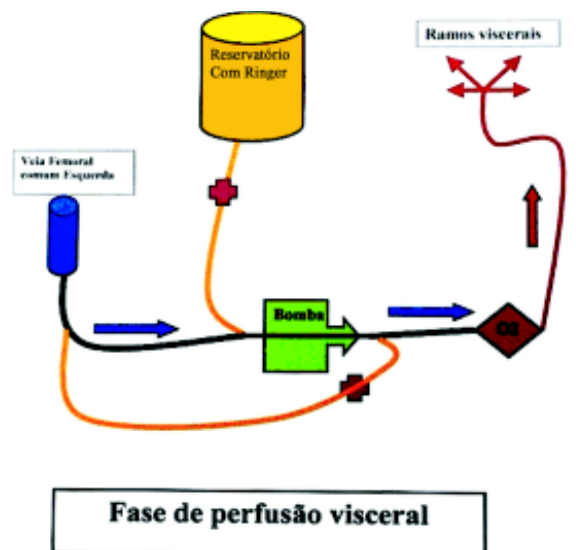
Fig. 1 - Em amarelo reservatório de cardiotomia e a linha de conexão no circuito. Nesta fase estas linhas encontram-se pinçadas (cruz em vermelho). Em azul, cânula venosa inserida na veia